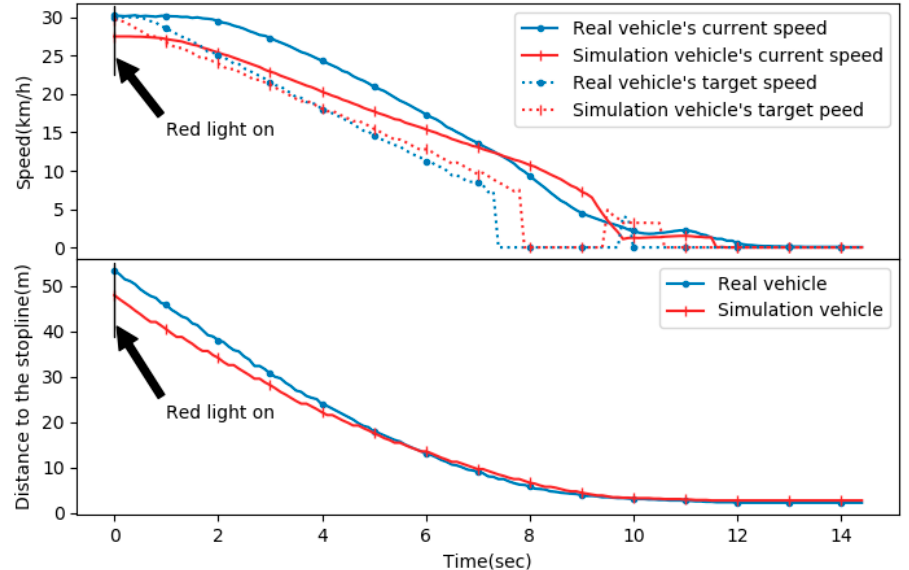
Figure 18. Real vs. simulation: vehicle current and target speeds ( upper ), the distance to the stop line ( lower ). In the upper graph, the solid blue line is the real vehicle’s current speed, and the solid red line is the simulation vehicle’s current speed. The dashed blue line is the real vehicle’s target speed, and the dashed red line is the simulation vehicle’s target speed. In the lower graph, the distance to the stop line, the solid blue line is the remaining distance to the stop line of the real vehicle, and the red solid line is the remaining distance to the stop line of the simulation vehicle.